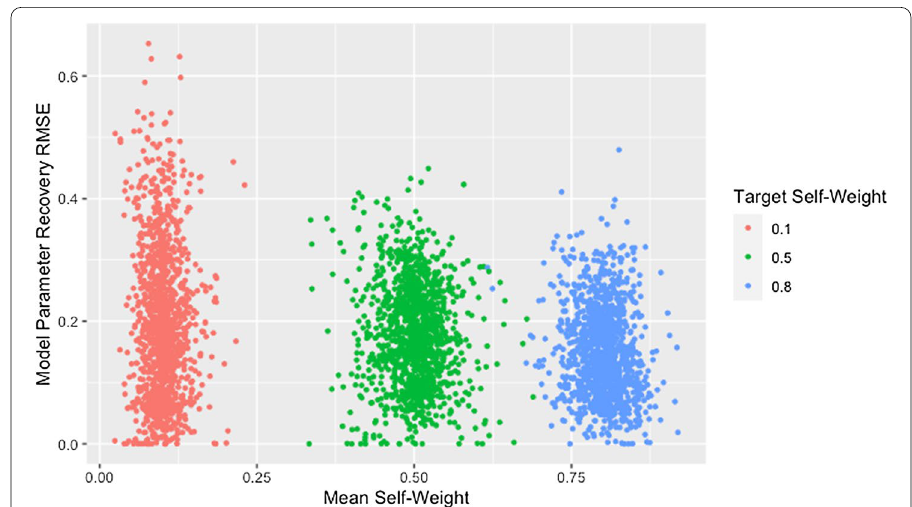
Fig. 4 RMSE for model parameter recovery by self-weight. RMSE for known and predicted weights by observed mean self-weight and target